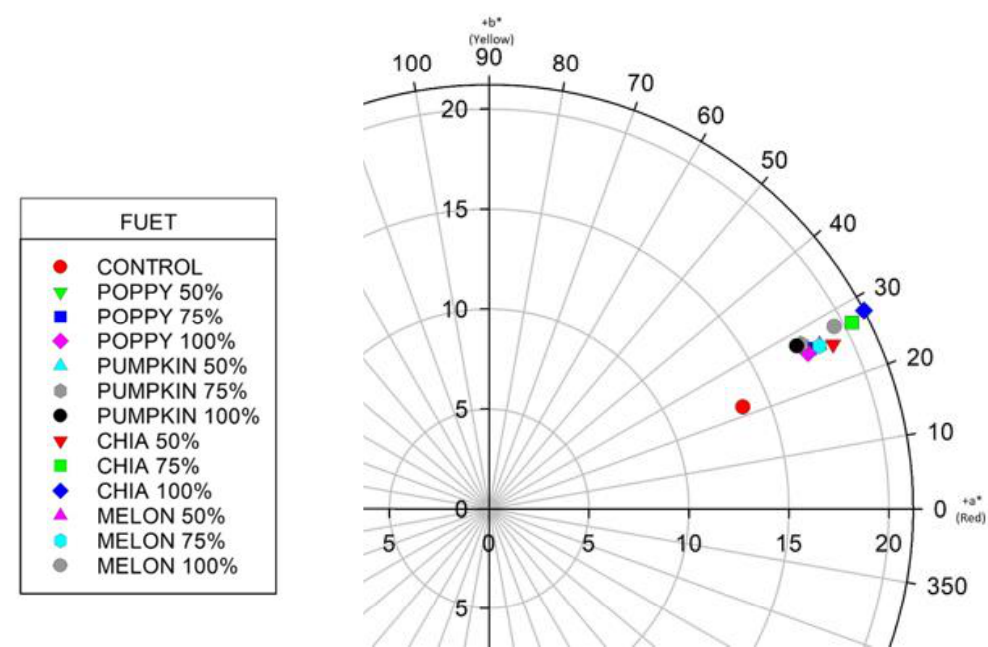
Figure 1. Graphical representation, in the CIELAB color space, of the results obtained for color of the fuet samples produced with different emulsified seed oils.